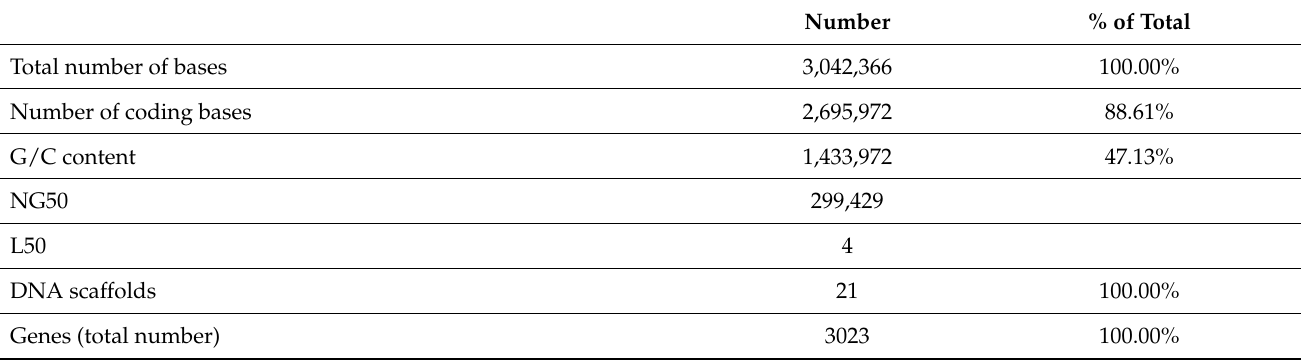
Table 1. Genome characteristics of R. meliponini